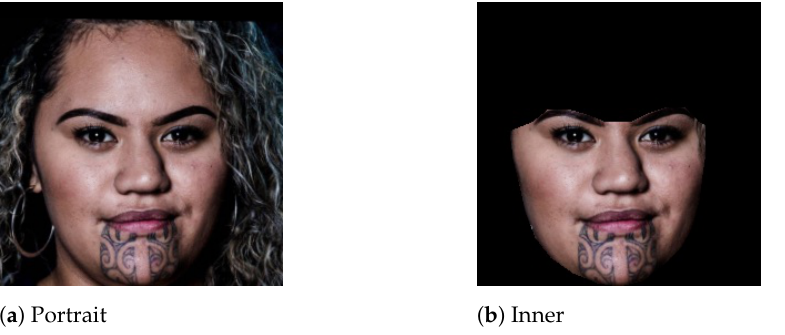
Figure 13. Examples of ( a ) a full portrait image where the entire face is visible and ( b ) a crop of the inner face region.